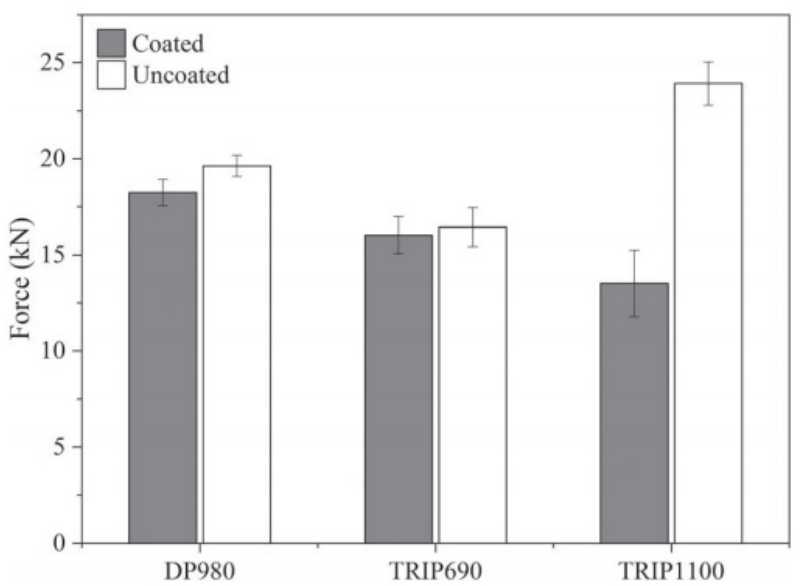
Figure 14. Mean lap shear strength for each material, coated and uncoated. Reprinted from [101], with permission of Taylor and Francis, 2019,